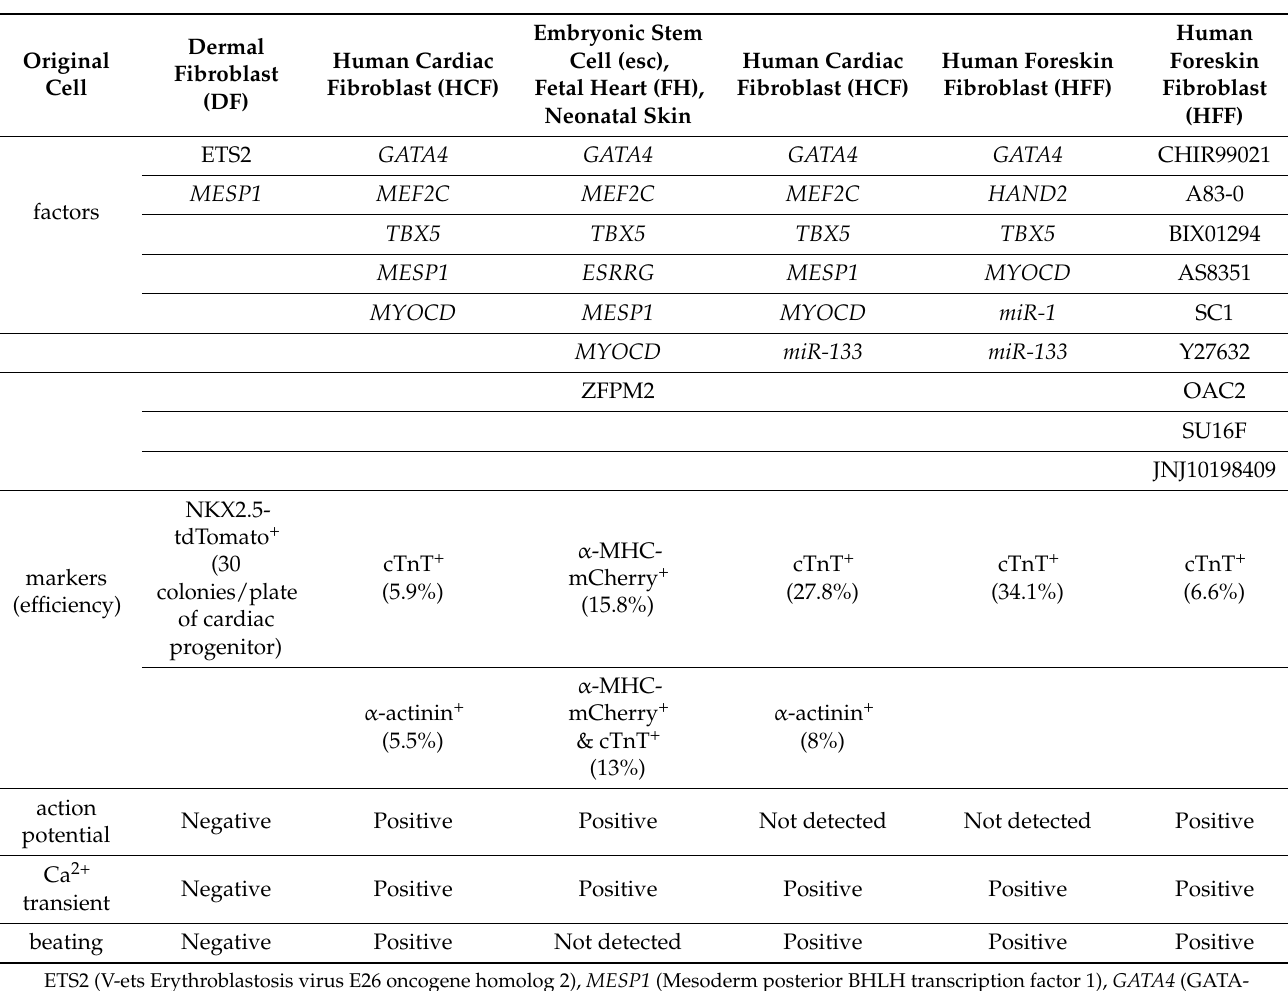
Table 2. Factors used for transdifferentiating somatic cells directly into cardiomyocytes